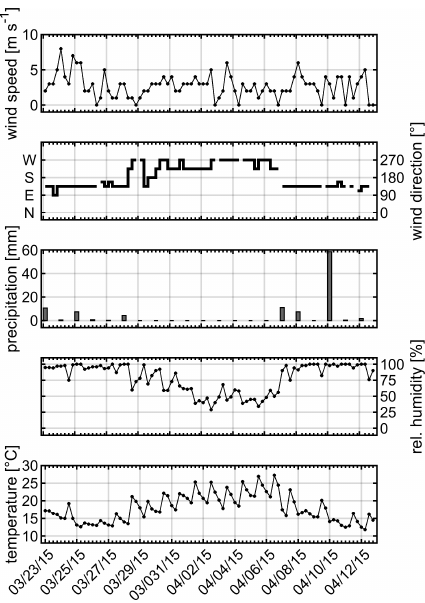
Figure 2. Time series (local time) of observed meteorological con- ditions at PDI during the sampling campaign from 23 March to 12 April